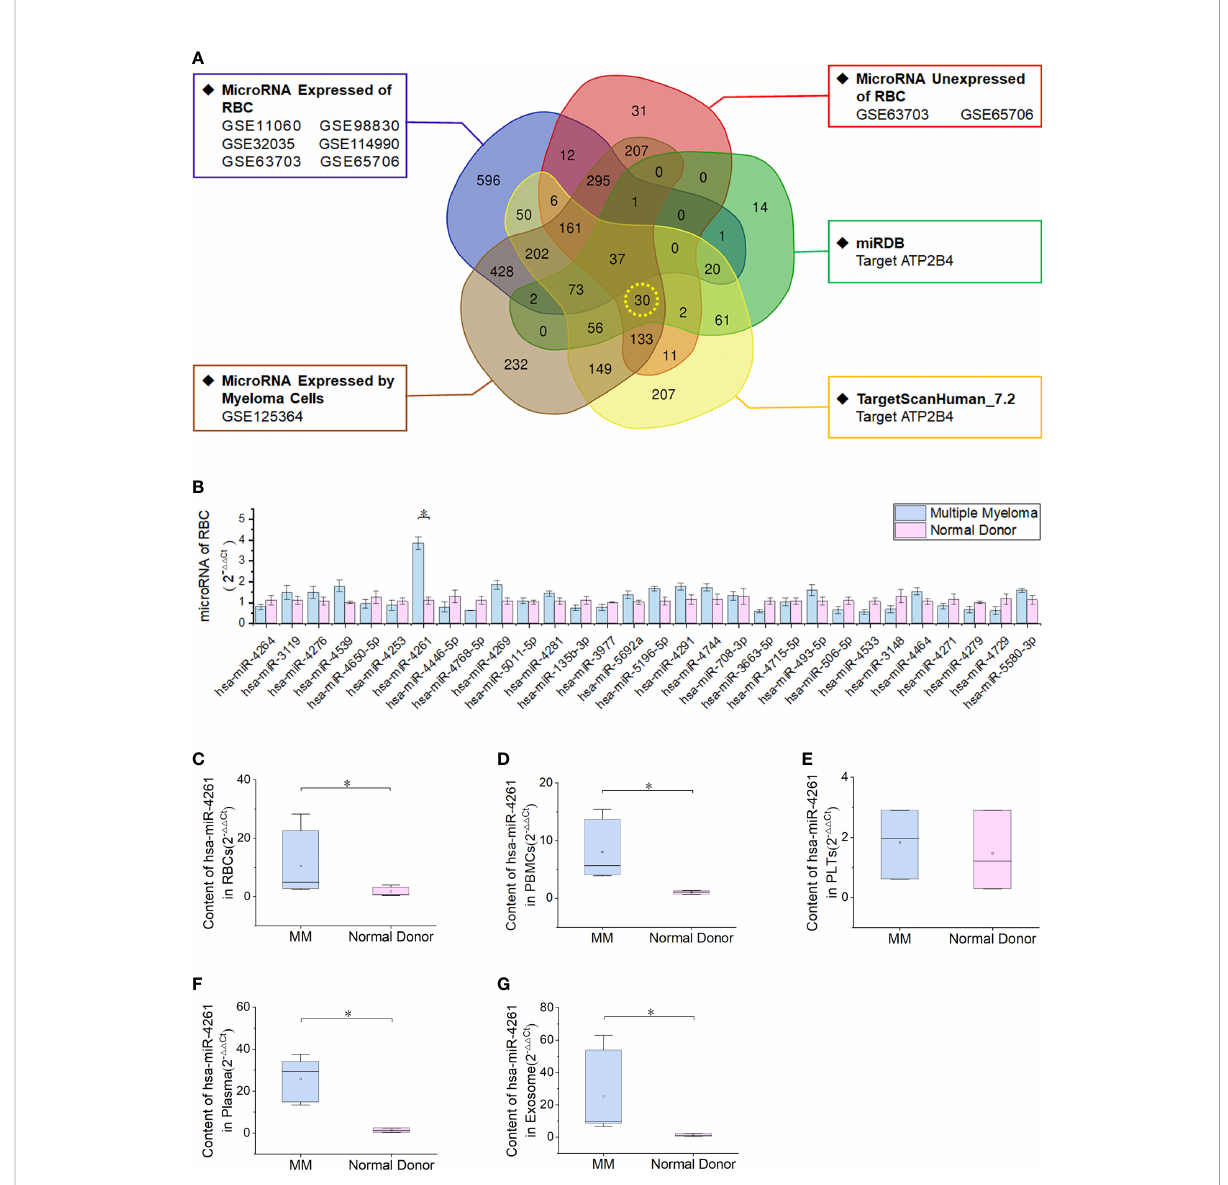
FIGURE 3 MiRNA-4261 targeting the ATP2B4 gene is highly expressed in MM. (A) Screening miRNAs by Venn diagram. The conditions were the following: expression in myeloma cells; lack of expression in normal RBCs; and target gene of ATP2B4. (B) qRT – PCR con fi rms that miR-4261 is highly expressed in MM RBCs ( P = 9.2E-03). (C – G) qRT – PCR was used to measure the content of miR-4261 in various components in blood samples ( P RBC = 2.3E-02, P PBMC = 2.3E-02, P platelet = 0.66, P plasma = 3.7E-02, P exosome = 2.8E-02). (Error bars represent the mean ± SEM, *P <